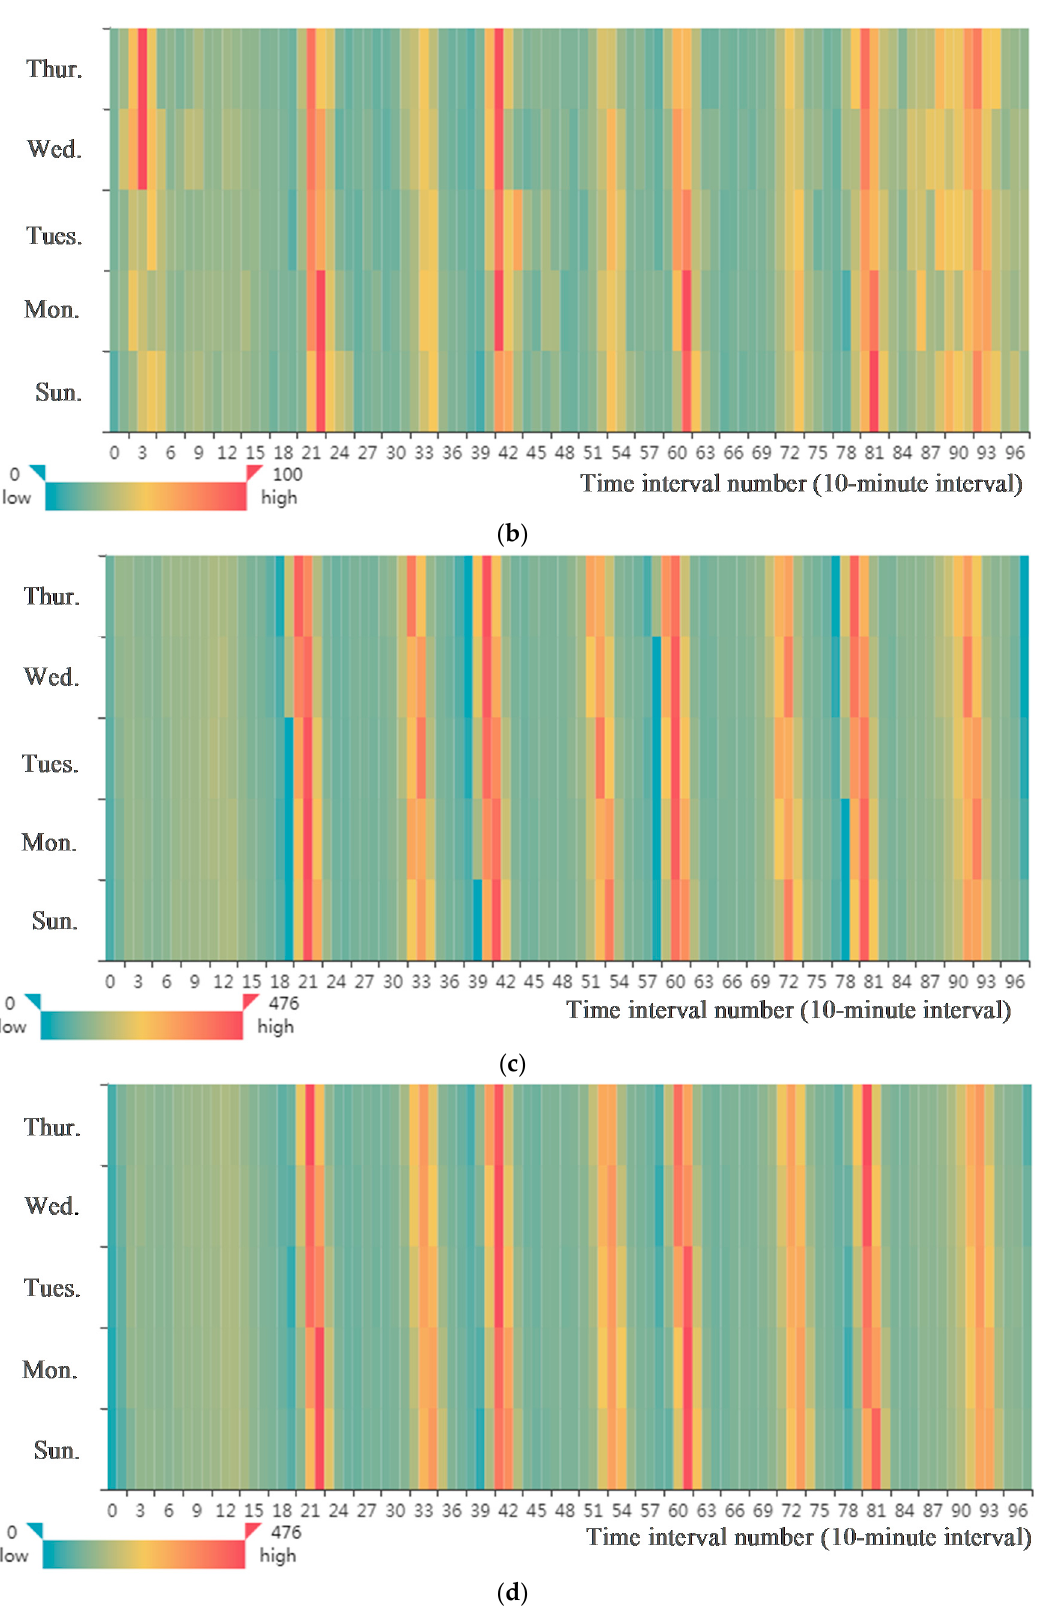
Figure 16. The RMSE distribution of ( a ) the passenger inflow volume at each 10-min interval, ( b ) the passenger outflow volume at each 10-min interval; and the time mean actual value (TMAV) distribution of ( c ) the passenger inflow volume at each 10-min interval and ( d ) the passenger outflow volume at each 10-min interval.